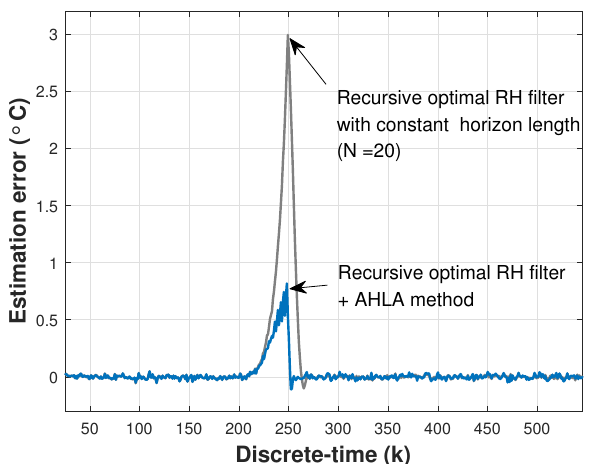
Figure 4. Estimation errors of standard and AHLA method-based recursive optimal RH